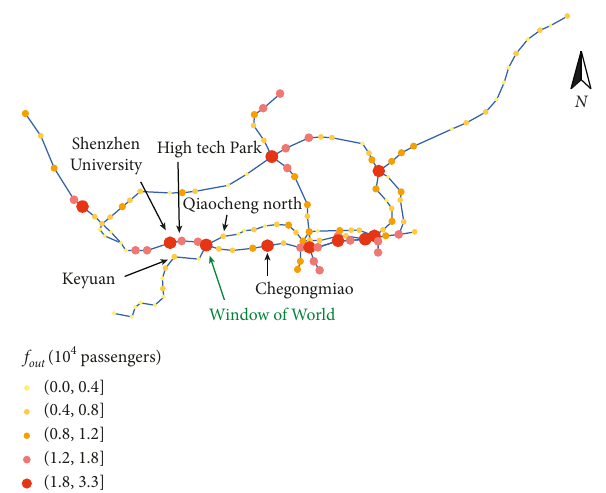
Figure 1: The subway network of Shenzhen. The blue lines rep- resent the subway lines. Colour and size of each circle denote the average daily out-passenger flow of the subway